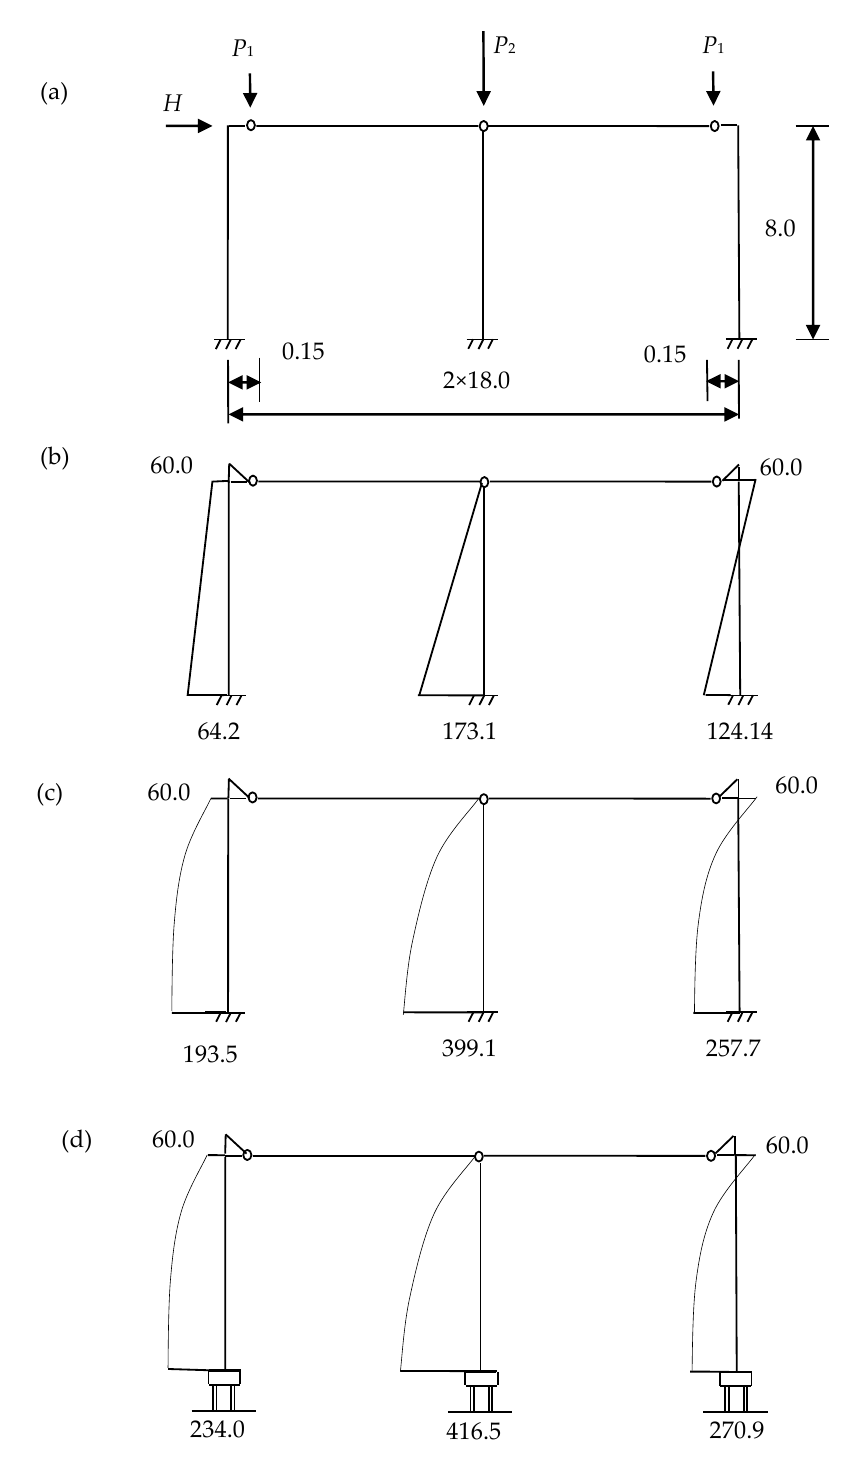
Figure 11. ( a ) Diagram of the frame of Example 2, ( b – d ) bending moments in the columns [kNm] according to the first-order theory and the second-order theory in the case of full restraint and pile foundation, respectively.